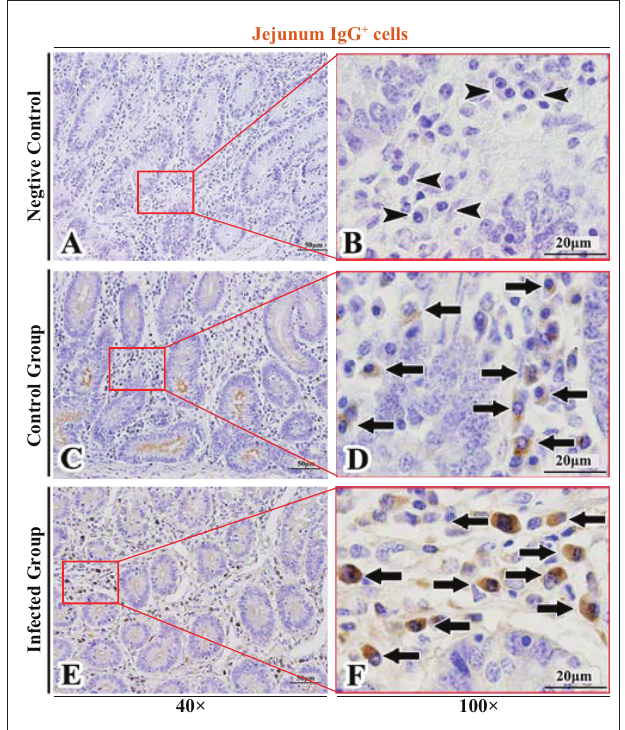
FIGURE 5 | Distribution of IgA + cells in sheep jejunum. (A,B) are negative controls; (C,D) are Control groups; (E,F) are Infected groups. Triangular arrows indicated plasma cells, arrows indicated IgA + cells, and the right image (Scale bar, 20 µ m) is a magnification from the part of the left image (Scale bar, 50 µ m).